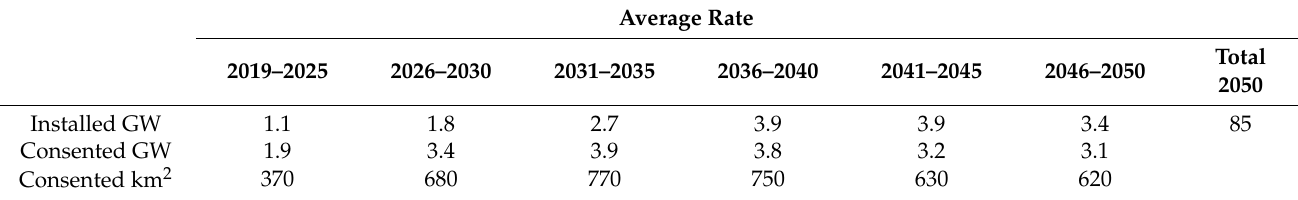
Table 3. Required installation rates in the Atlantic